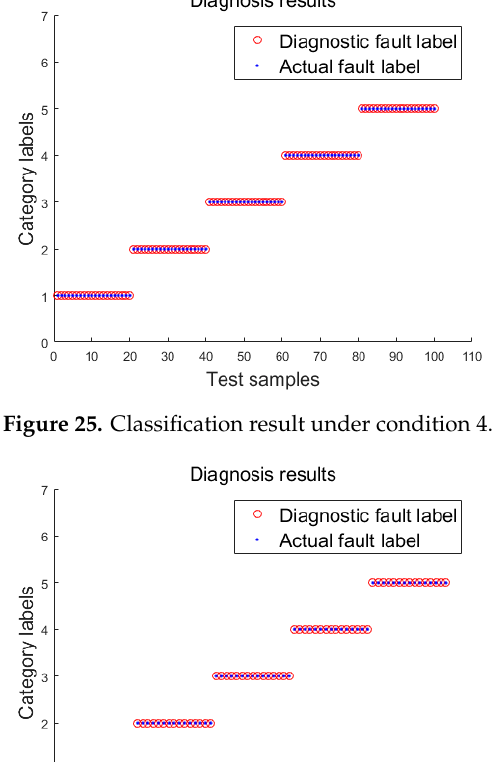
Figure 24. Classification result under condition 3. Appl. Sci. 2019 , 9 , x FOR PEER REVIEW